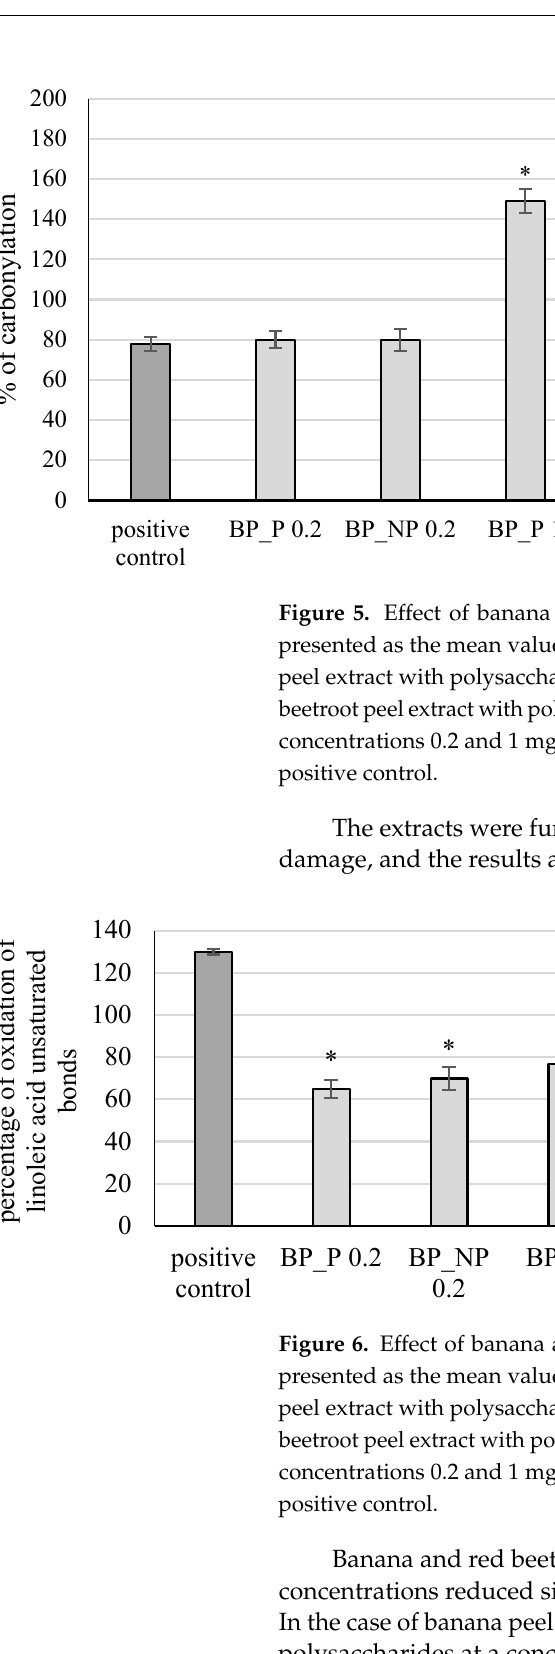
Figure 6. Effect of banana and red beetroot peel extracts on damage of linoleic acid. Results are presented as the mean value +/ − standard deviation of 3 independent experiments. BP_P ‐ banana peel extract with polysaccharides; BP_NP ‐ banana peel extract without polysaccharides; RBP_P ‐ red